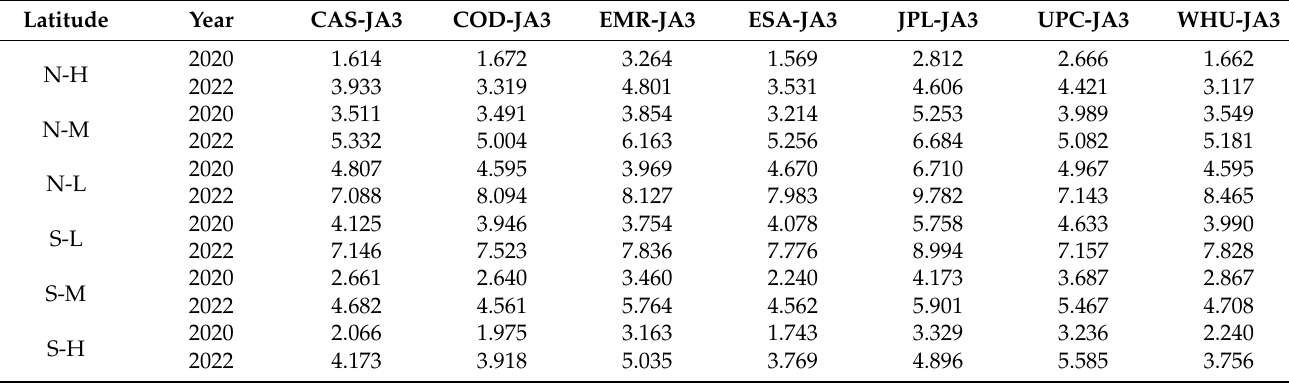
Table 4. RMS values of different GIMs in 2020 and 2022 relative to Jason3 in different latitudinal bands, in the units of